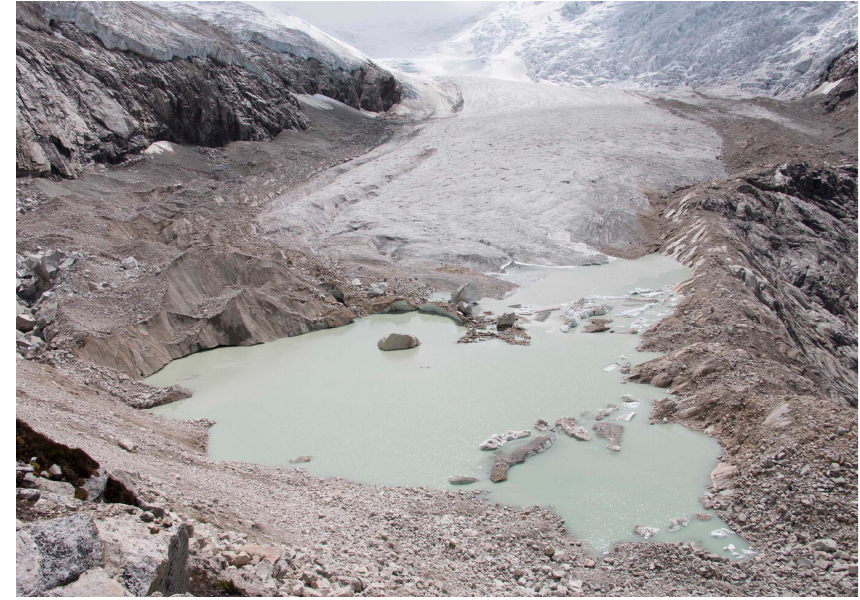
Figure 1. Initial lake formation at Glaciar Artesonraju, Cordillera Blanca. The now already visible large pond may connect to the main lake, which is modeled to develop further up-glacier during the coming years to decades in the marked bed overdeepening underneath the flat glacier tongue (cf. Figure 5). Photography by D. Colonia, February